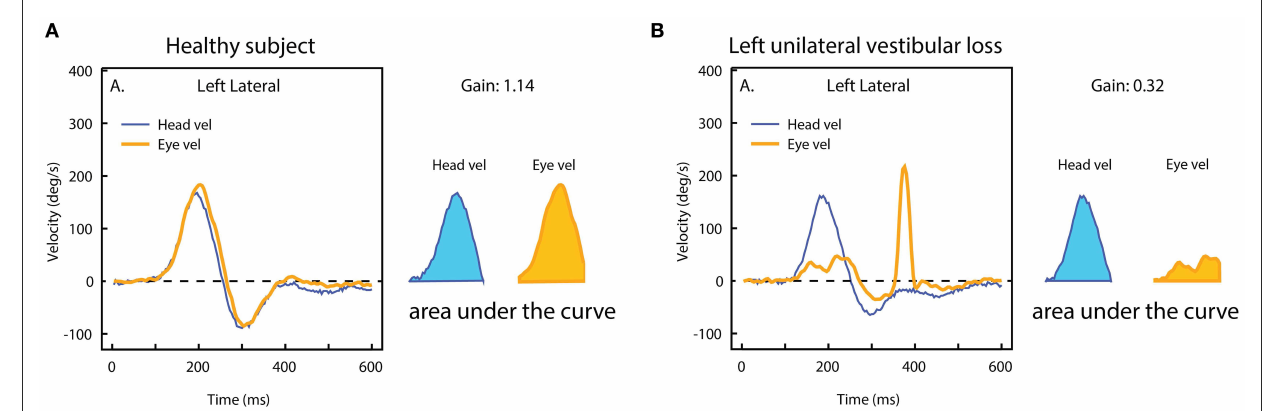
FIGURE12 The area VOR gain. The area under the eye velocity during the head impulse is divided by the area under the head velocity. The ratio of the areas in (A) is around 1.0, but in case of unilateral vestibular loss (B) , the eye velocity area is much smaller, and so the area VOR gain is much smaller (0.3) [Reproduced from Curthoys and Manzari (11) with